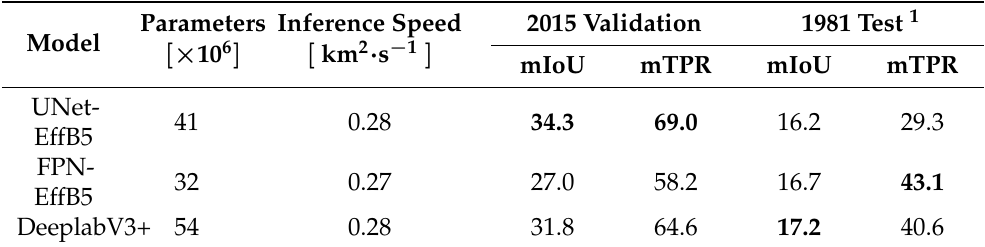
Table 6. Summary of semantic segmentation results using UNet-EffB5 on the MiniFrance (MF) validation set using RGB, greyscale or historical-like (CycleGAN translated)